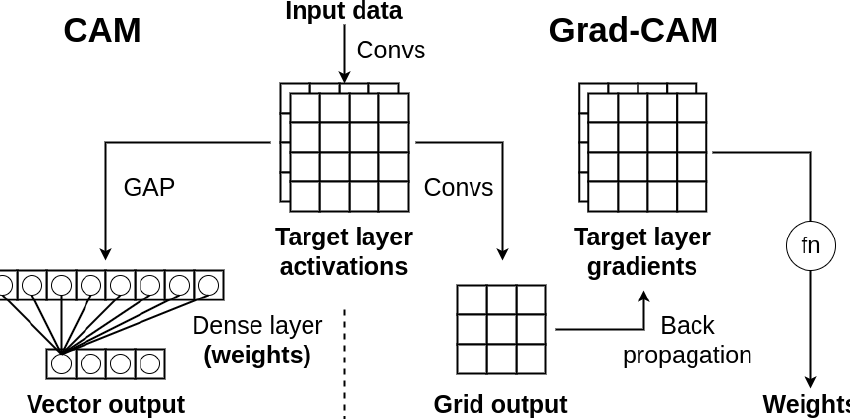
Figure 1. Algorithm scheme comparison between CAM and Grad-CAM methods. Target activations are the same for both methods. The difference is observed in activation weights; in CAM, we derive them from dense layer weights, whereas in Grad-CAM we use backpropagation to obtain gradients of target layers and calculate weights based on